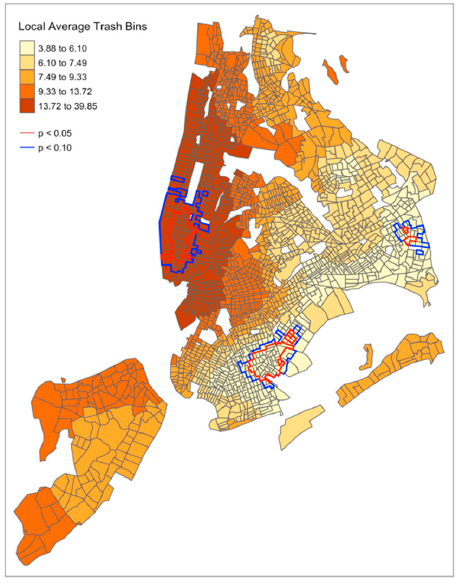
Figure 2. Mapping test of spatial dependence of litter bin count by census tract in New York City.